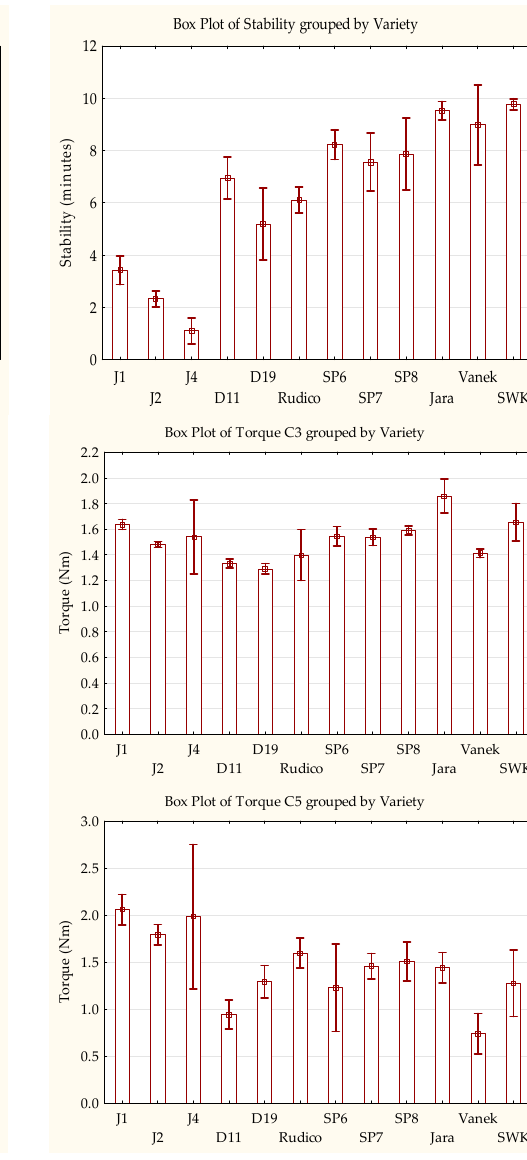
Figure 5. Parameters of Time C1, Stability, Torque C2, Torque C3, Torque 4, and Torque C5 in the measured Mixolab. Data are the means of 12 wheat varieties at three locations, three replicates, in three years ( n = 36). Box plots represent the interquartile range, the columns in the box symbolize the mean value, and whiskers designate the minimum and maximum of the box plot.